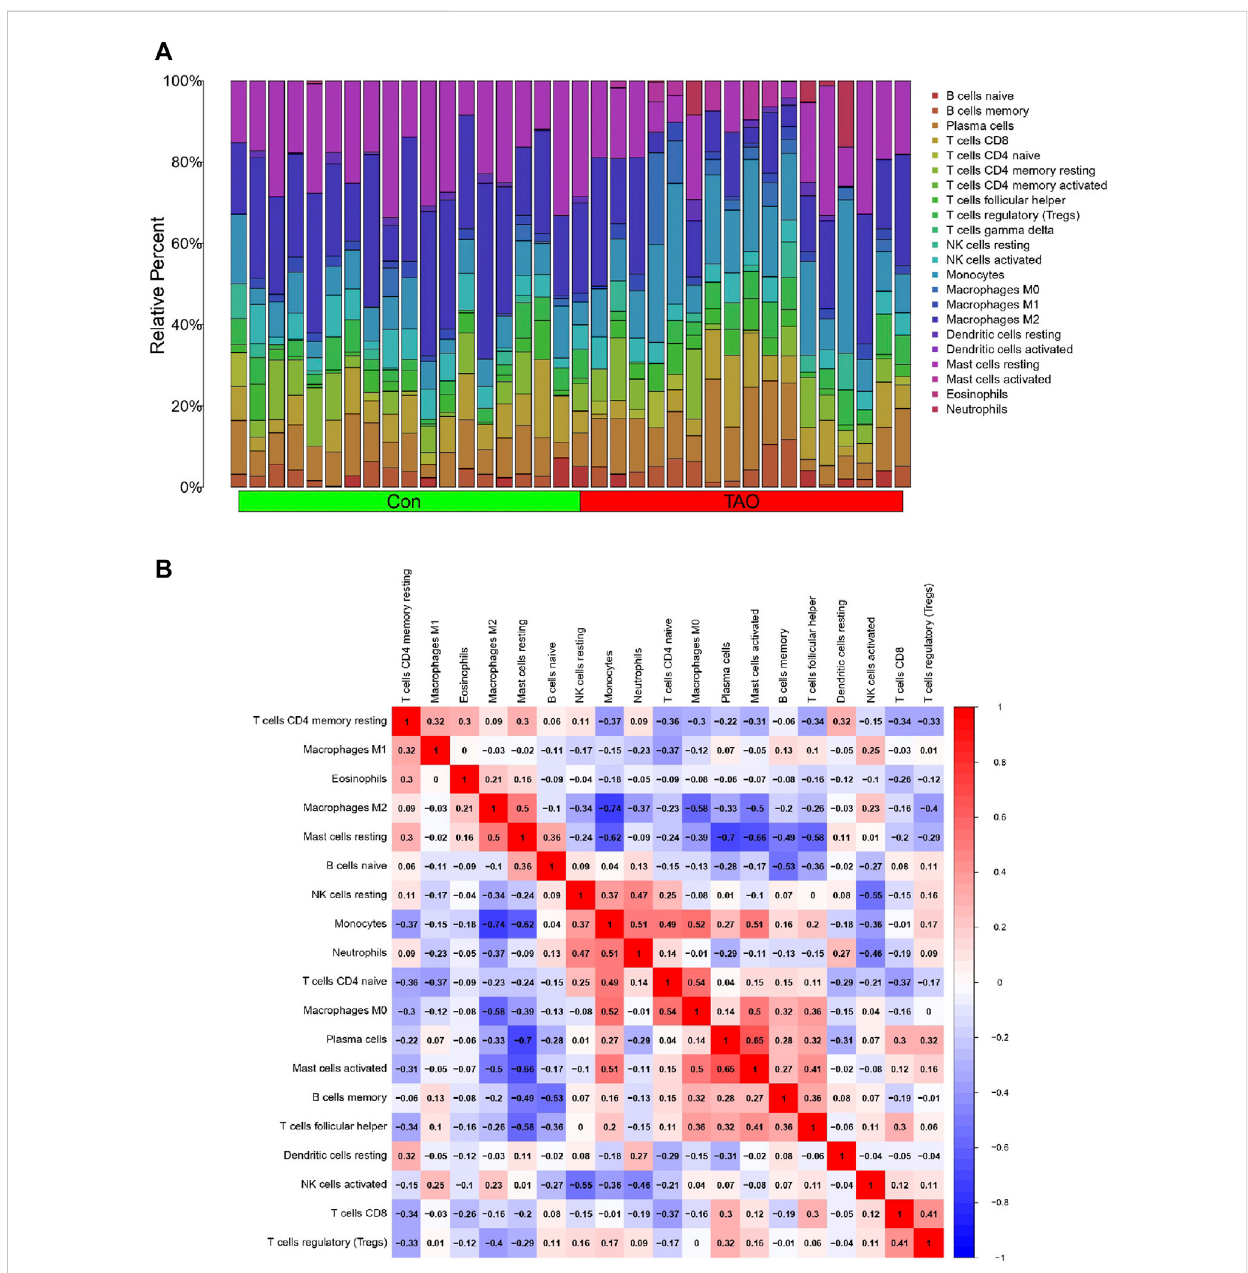
FIGURE 5 Immune cells in fi ltration analysis. (A) The bar plot of 22 types of immune cell in fi ltration status in each sample. The green and red rectangle in the bottom represents the control and TAO groups, respectively. The Y coordinate indicate the relative percent of each immune cells in all immune cells. (B) Heatmap of immune cells correlation. Both the X and Y coordinate are the names of immune cells. The values inside squares represent the correlation between immune cells, with orange representing positive correlation and blue representing negative